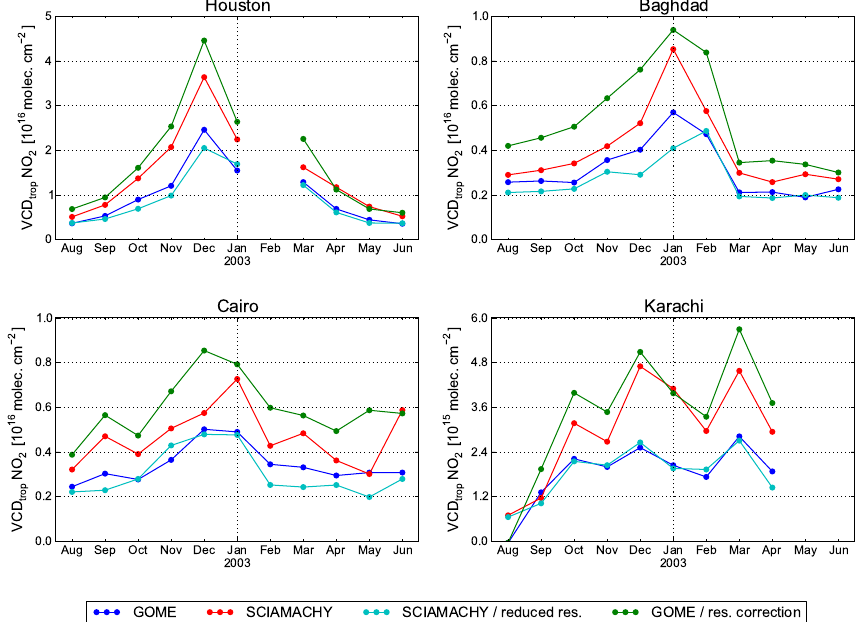
Fig. 9. Monthly averages of VCD trop NO 2 over four exemplary areas showing a significant over-correction, for the time period August 2002–June 2003. Only those days for which both GOME and SCIAMACHY measurements for a city are available are taken into account.